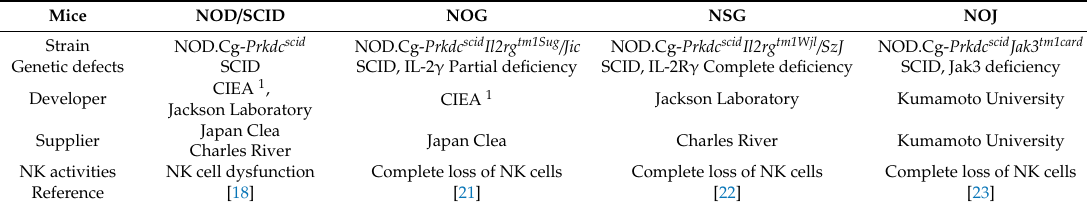
Table 1. NOD / SCID-based immunocompromised mice.